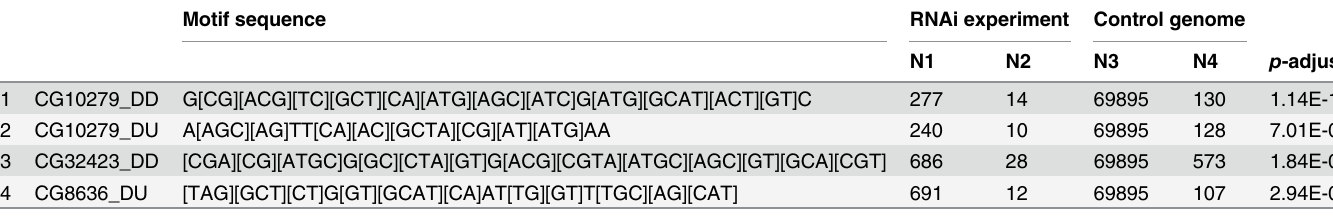
Table 3. Significant sequence motifs detected at flanking regions of alternative splicing sites. Motif